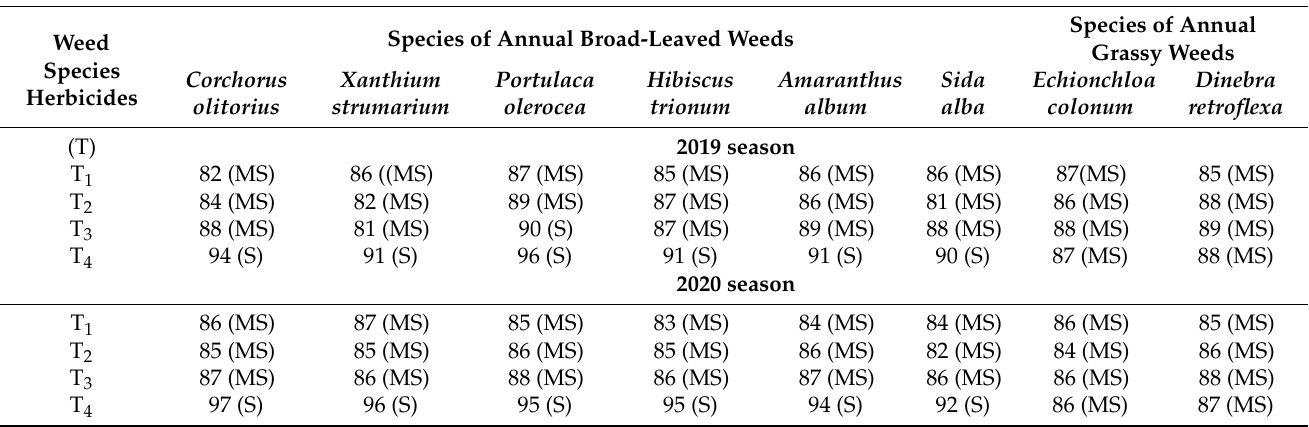
Table 6. Susceptibility score of weed species to herbicides after 60 days from application during the 2019 and 2020